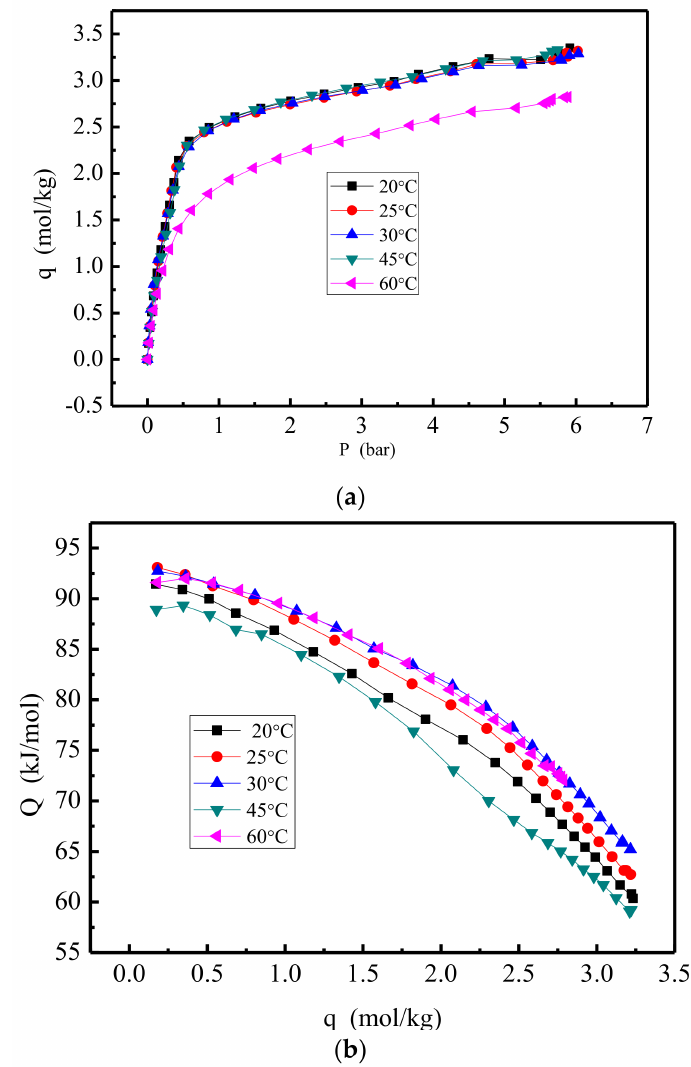
Figure 3. Amount and isosteric heat of CO 2 adsorption in the solid amine. ( a ) Isotherm adsorption in the solid amine. ( b ) Isosteric heat of adsorption in the solid